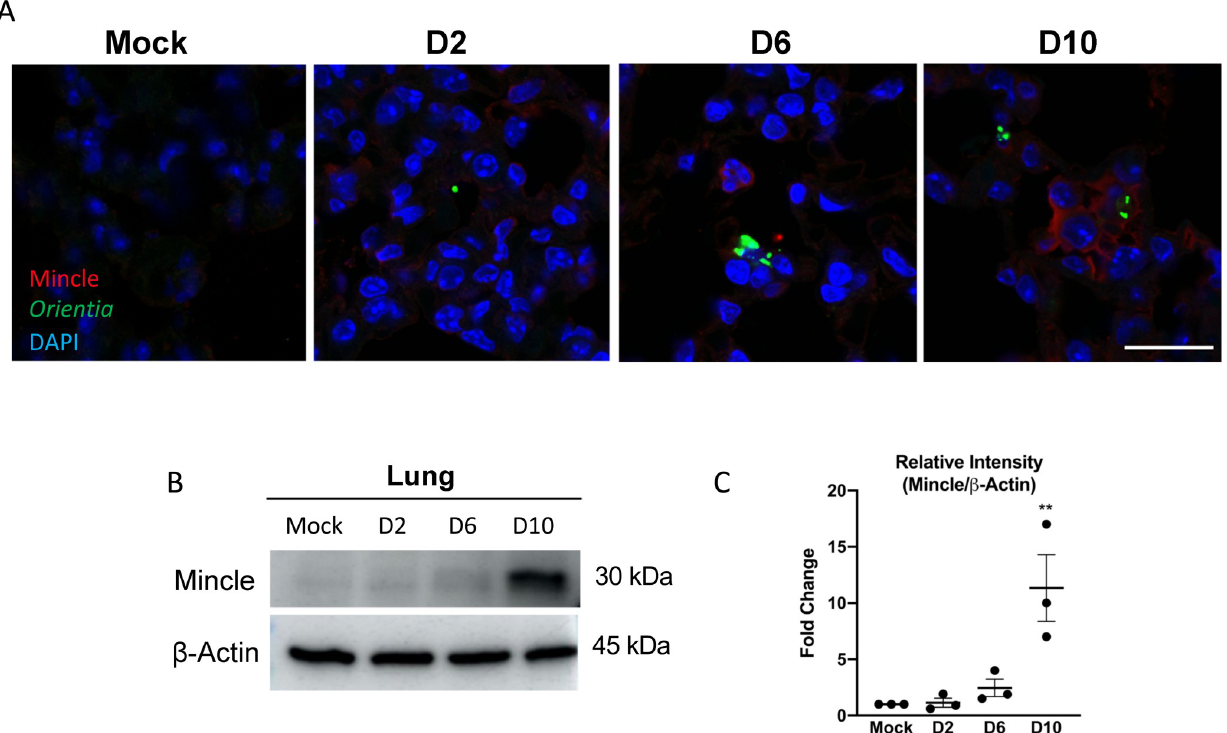
Fig 4. Mincle protein distribution and levels in the lungs of terminal disease. (A) Immunofluorescent assay detection of Mincle (red), O . tsutsugamushi (green), and DNA (DAPI, blue) in frozen lung sections prepared at the indicated days of infection. Images were taken under the same magnification (scale bar = 20 μ m). (B) Western blots (40 μ g protein/lane) of lung tissues of lethally infected mice for the levels of Mincle and β -actin. (C) Densitometry of representative blots from 3 independent experiments were measured via ImageJ. Fold changes were determined relative to Mincle proteins in mock samples and shown as mean ± SEM. One-way ANOVA with Dunnett’s multiple comparison test was used for statistical analysis, with mock samples used as a reference. �� , p < 0.01.